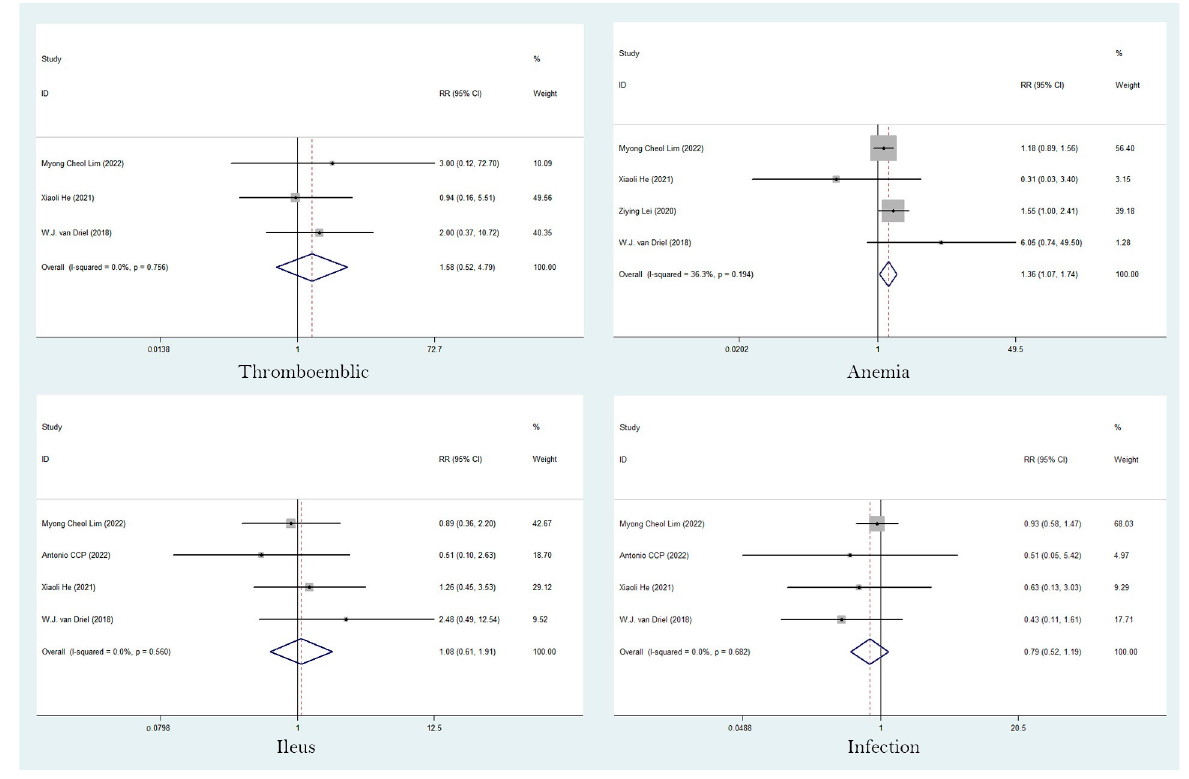
Figure 6. Forest plot of electrolyte disturbance.